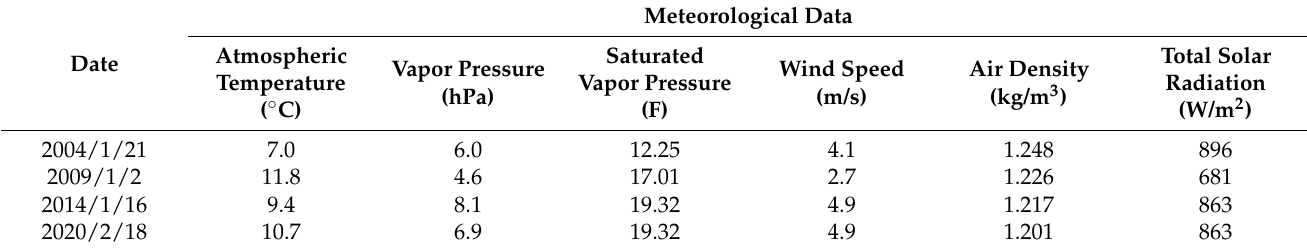
Table 2. Meteorological data of